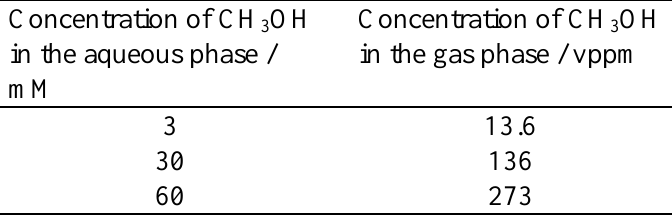
Table 1. Equilibrium gas phase concentrations above an aqueous methanol solution at 25 °C according to the Henry’s law constant given by Snider et al. [21] and equation (1) given by Sander [20].